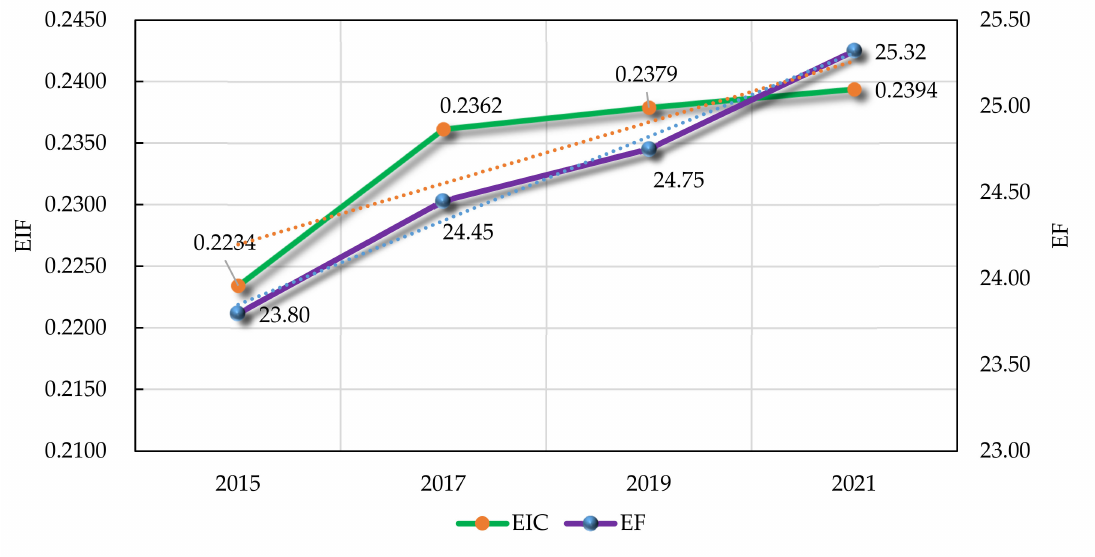
Figure 21. The changes in the EF and EIC in the headwaters of the Yangtze